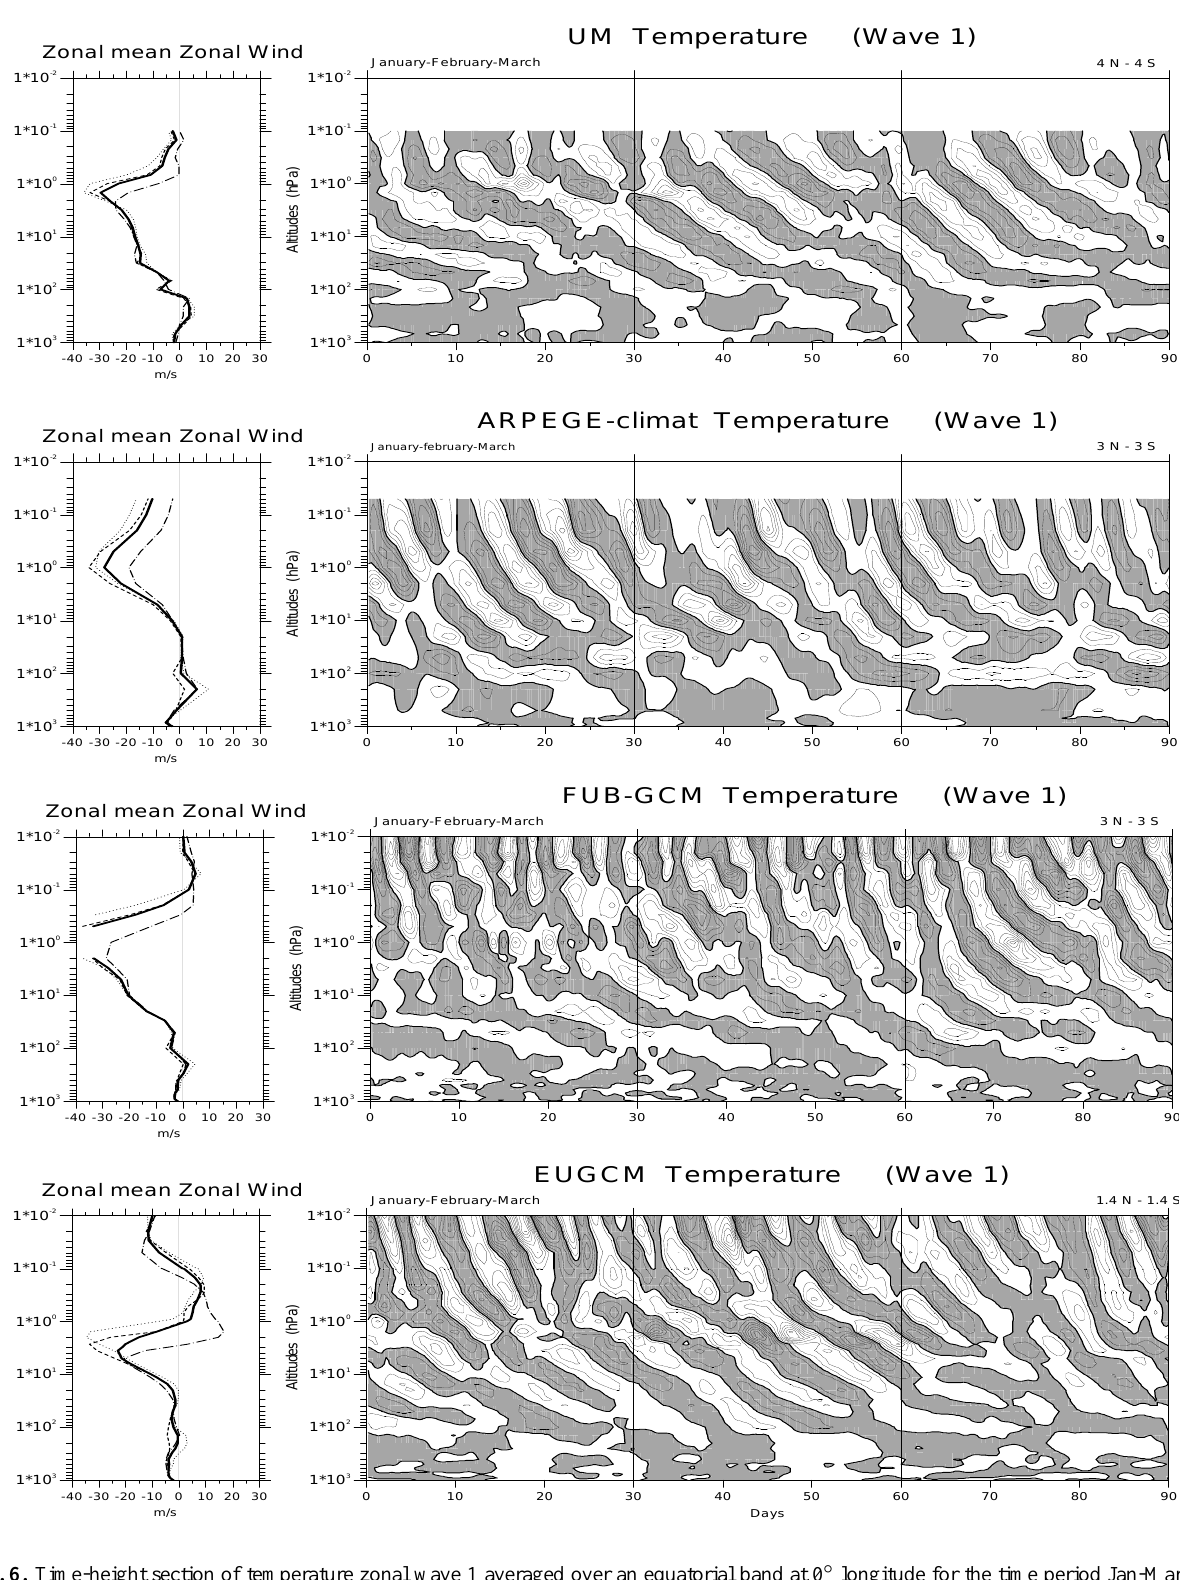
Fig. 6. Time-height section of temperature zonal wave 1 averaged over an equatorial band at 0 ◦ longitude for the time period Jan-Mar and Apr-Jun for the UM, ARPEGE-climat, FUB-GCM and EUGCM models. Positive values are shaded and the contour interval is 1 K. The solid lines of the left panel show the zonal wind profiles averaged over the 3 months Jan-Feb-Mar and Apr-May-Jun; dotted lines correspond to January and April, dashed lines to February and May and dash-dotted lines to March and